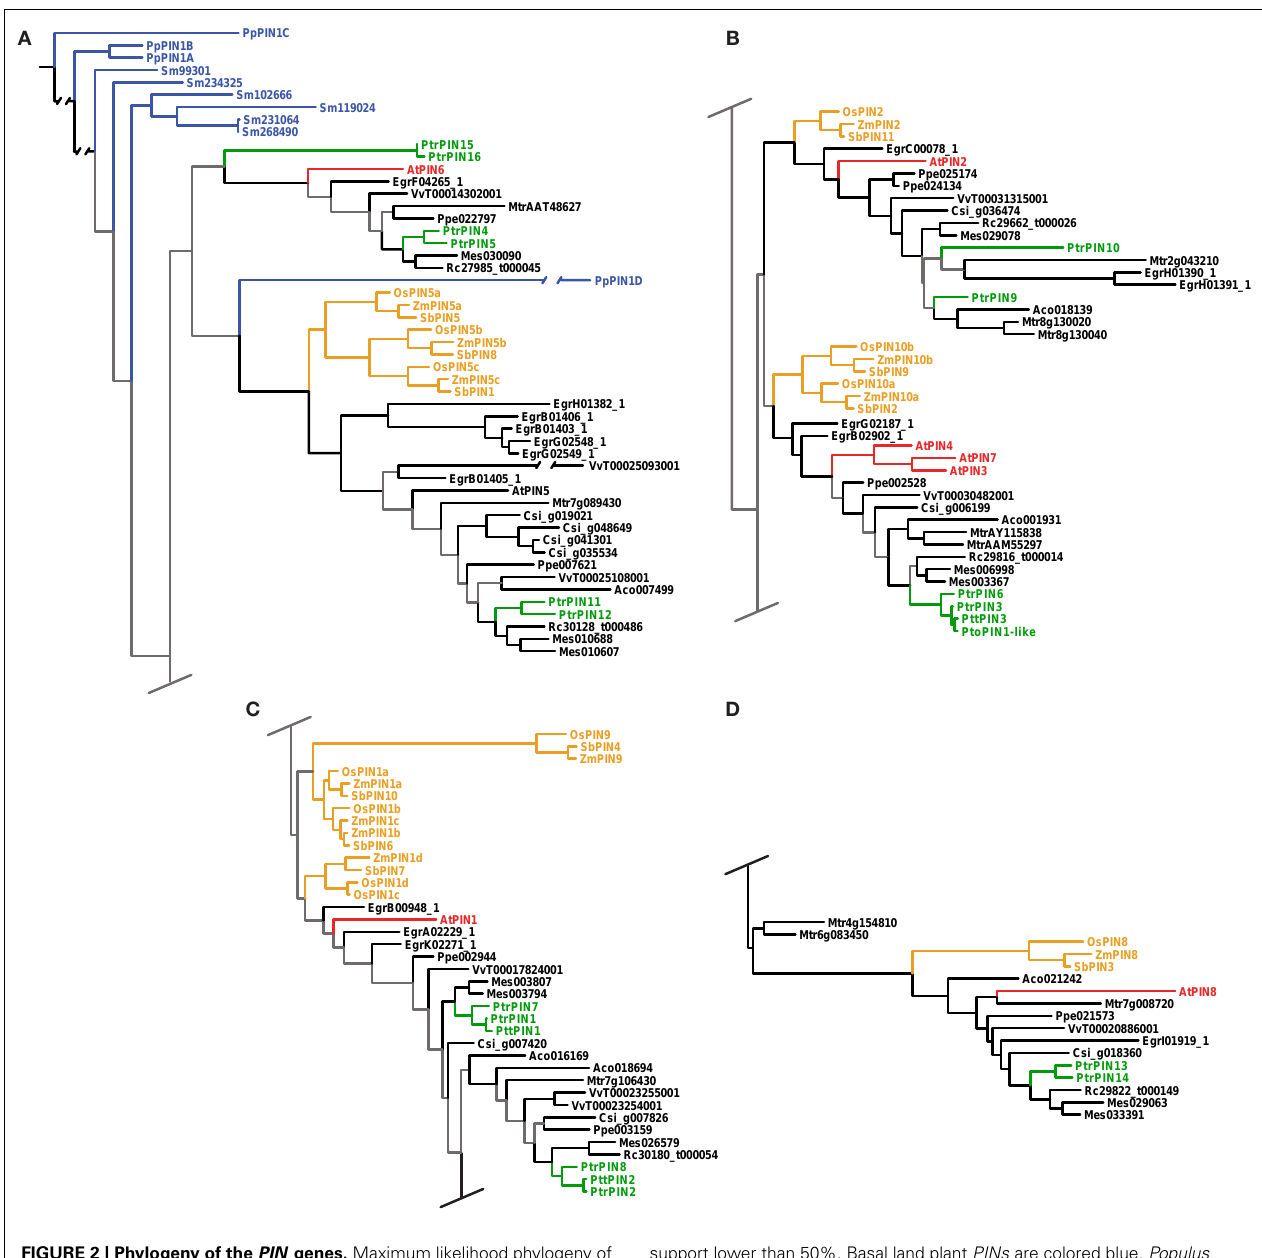
FIGURE 2 | Phylogeny of the PIN genes. Maximum likelihood phylogeny of PIN genes from land plants, based upon coding sequences from the loci listed in TableA4 in Appendix. Gray branches indicate nodes with bootstrap